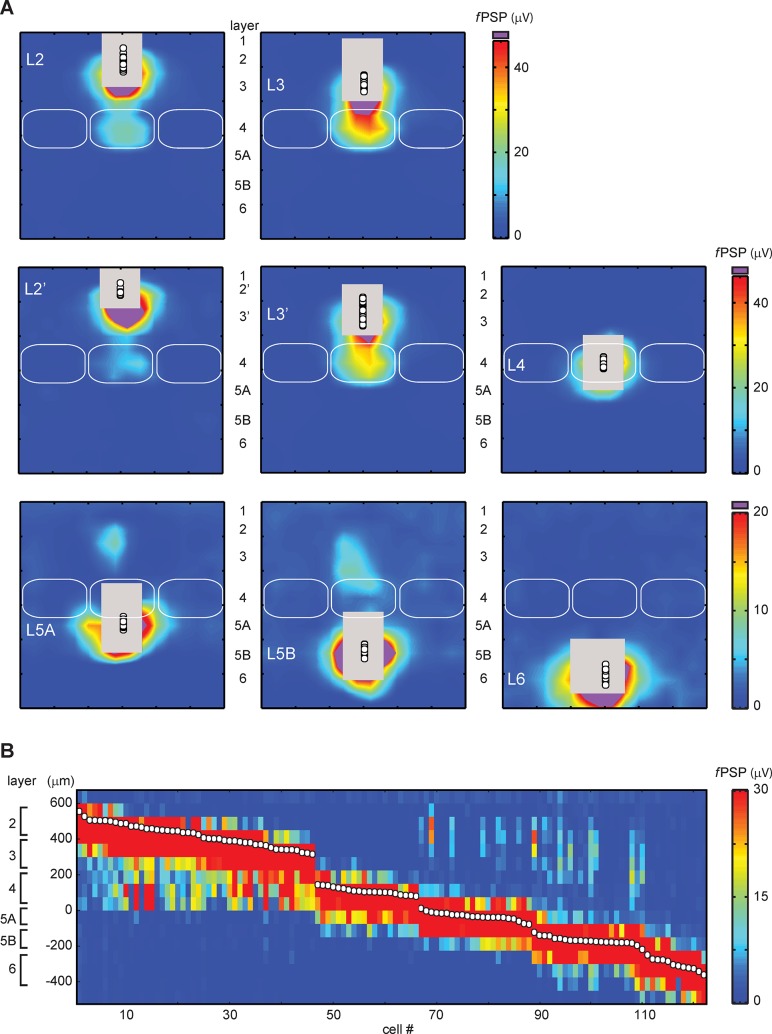
fPSP maps are generated for every layer of barrel cortex.
A, Group-average maps for the layer 2, 3, 4, 5A, 5B and 6. L2 and L3 group-average maps were generated according to two conventions: In the upper row, L2 and L3 had similar thicknesses (n = 24 and 22 recordings, respectively). In the middle row, L2 was a narrow band (68 μm) below L1 and L3 was thicker (n = 10 and 36, respectively). L4, n = 20; L5A, n = 20; L5B, n = 21; L6, n = 12. Regions in purple are where fPSP peak amplitudes were greater than the upper limit of the color scale. Regions in grey are where directly-evoked responses prevented fPSP measurement. The solid white circles indicate the recording positions. B, Stack of maps for 122 recordings each compressed in one dimension.